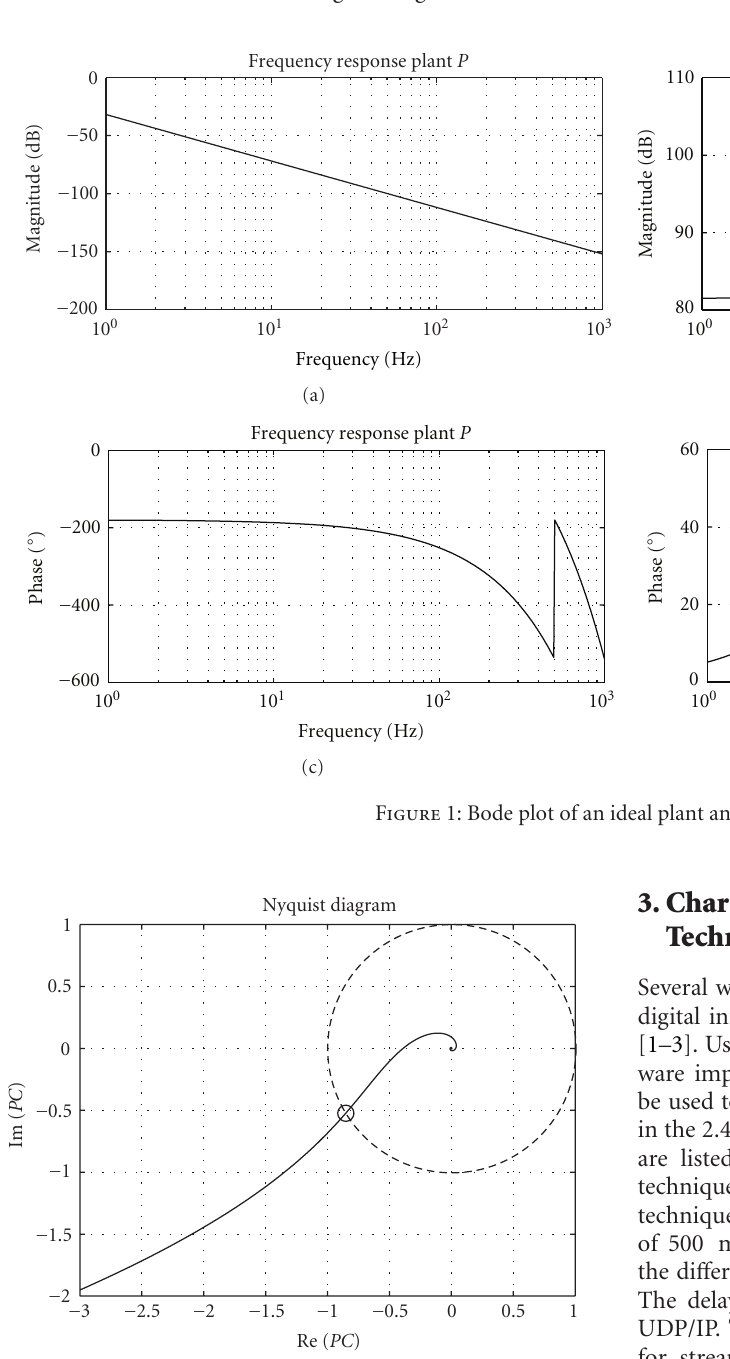
assumed that 64 bits of data per packet is su ffi cient to transmit the necessary information. However, in wireless data transfer additional bits are necessary to encode the data into packets. Assuming that about two times the number of data bits is required and that 64 bits of data is sent at 2 kHz, the required data rate is finally estimated at 256